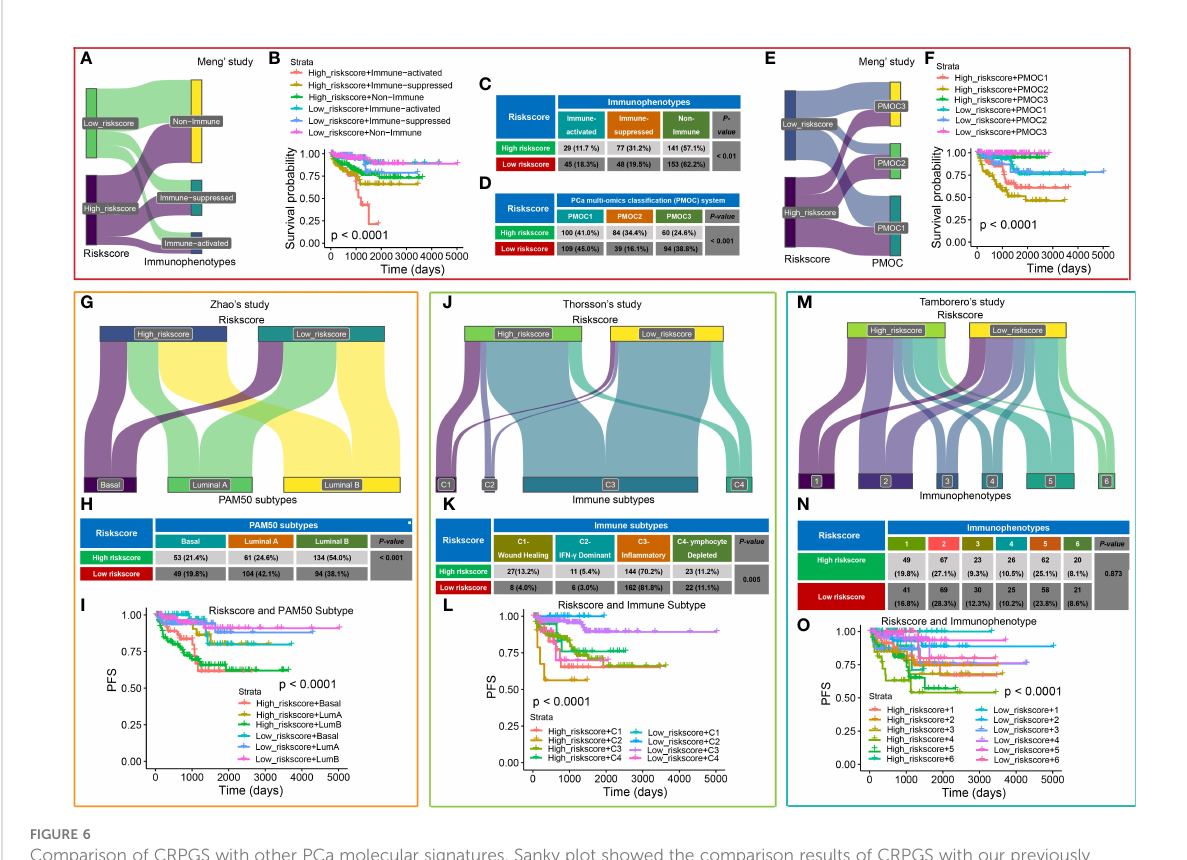
FIGURE 6 Comparison of CRPGS with other PCa molecular signatures. Sanky plot showed the comparison results of CRPGS with our previously established immune subtypes (non-immune, immune-suppressed, and immune-activated subtypes (A) , the combined effects of CRPGS + immune subtypes on PCa patients ’ survival (B) , and the c 2 test table showed the distribution of CRPGS in different immune subtypes (C) . For the PMOC subtypes, the c 2 test table showed the distribution of CRPGS in different PMOC subtypes (D) , the Sanky plot showed the comparison results of CRPGS with the PMOC subtypes (E) , the combined effects of CRPGS + PMOC subtypes on PCa patients ’ survival (F) . PAM50 classi fi er, Sanky plot showed the comparison results of CRPGS with PAM50 classi fi er (G) , and the c 2 test table showed the distribution of CRPGS in different PAM50 classi fi ers (H) , and the combined effects of CRPGS + PAM50 classi fi er on PCa patients ’ survival (I) . For Thorsson ’ s study, Sanky plot showed the comparison results of CRPGS with the four immune subtypes (J) , and the c 2 test table showed the distribution of CRPGS in the four immune subtypes (K) , and the combined effects of CRPGS + the four immune subtypes on PCa patients ’ survival (L) . For Tamborero ’ s study, Sanky plot showed the comparison results of CRPGS with the six immunophenotypes (M) , and the c 2 test table showed the distribution of CRPGS in different immunophenotypes (N) , and the combined effects of CRPGS + immunophenotypes on PCa patients ’ survival (O)